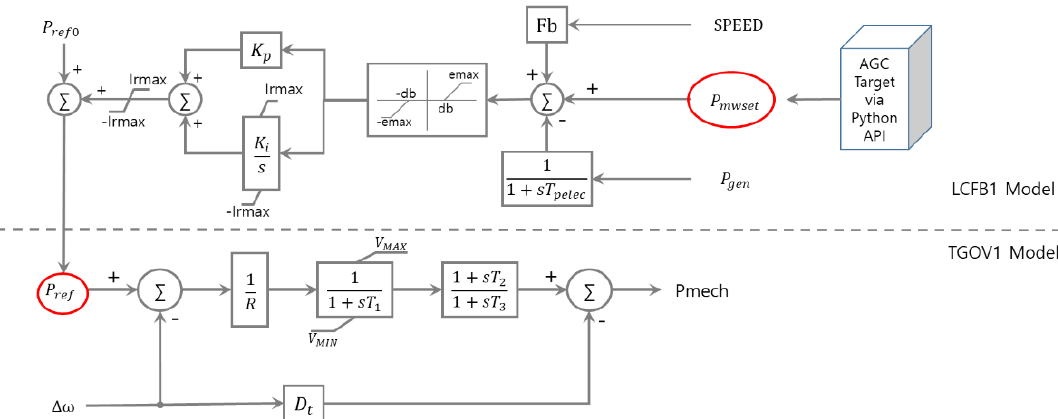
Figure 8. TGOV1 model interfacing with the LCFB1 model for simulating AGC.